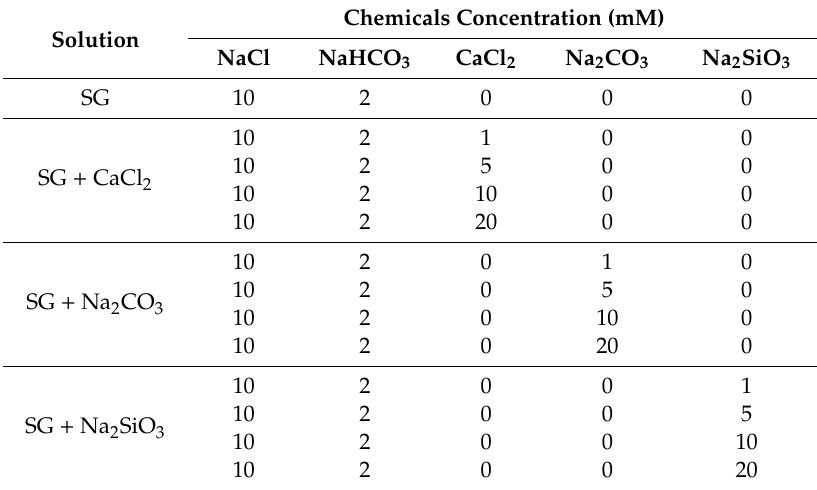
Table 2. Chemical composition of simulated